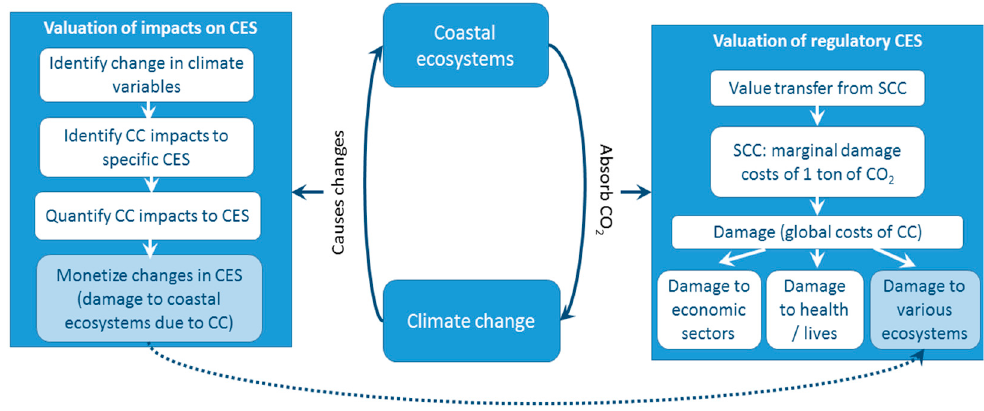
Figure 2. Links between climate change (CC), coastal ecosystem services (CES) and their valuation.